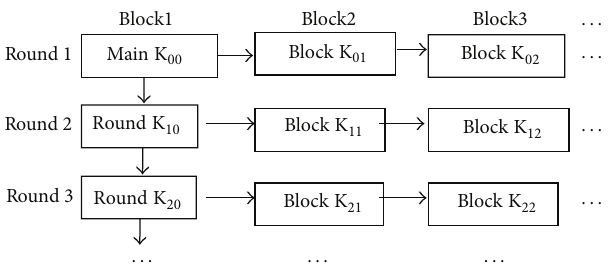
Figure 8: Relation of all kinds of keys.